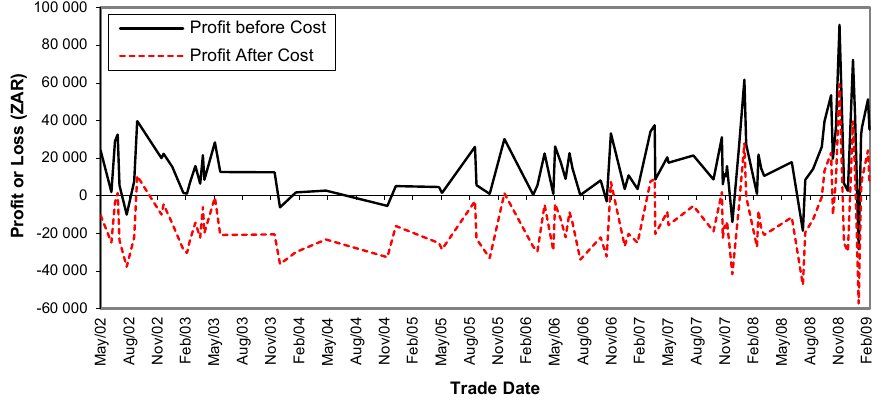
FIGURE 6: Profits and losses from the FSR-RMH analysis before and after trading costs are taken into account Source: Representation of simulation